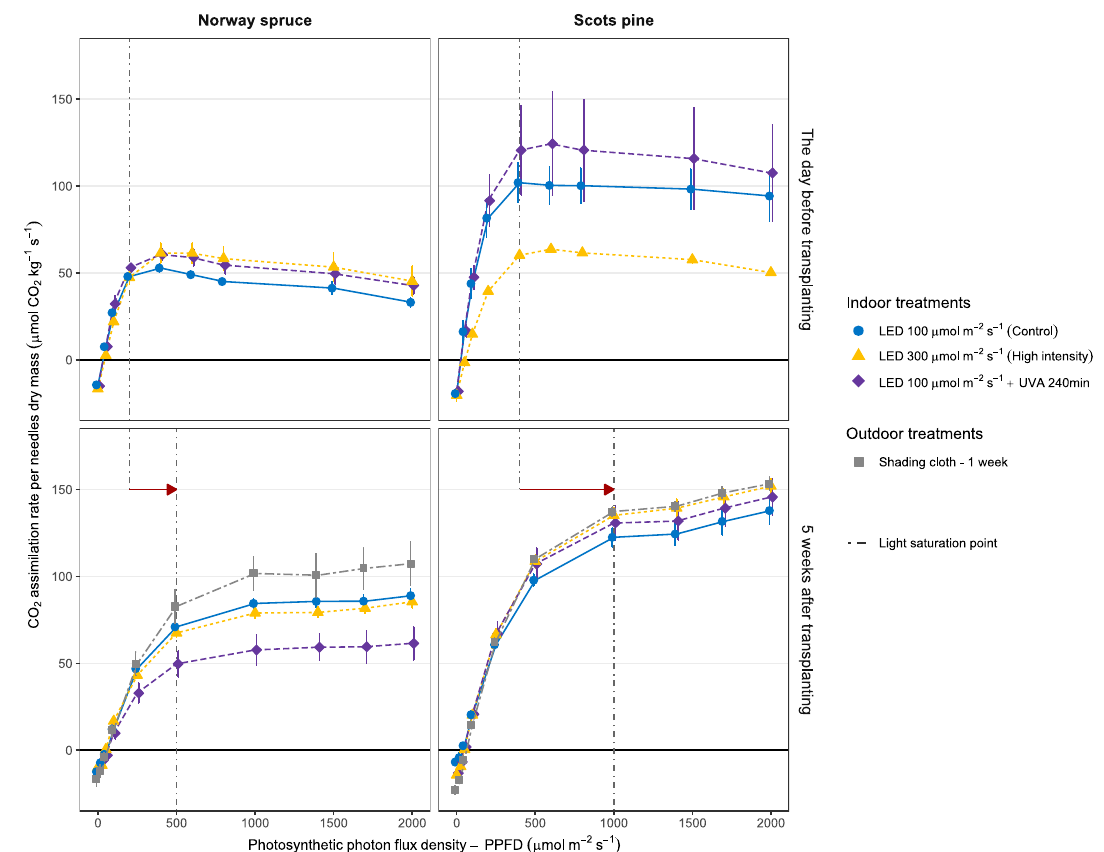
Figure 5. Average light-response curves for seedlings of Norway spruce and Scots pine cultivated indoors under LED lights. The net CO 2 assimilation was calculated relative to seedling’s needles dry mass as a function of the light intensity. The vertical dashed lines show the shift in the light saturation point after adapting to outdoor conditions. The error bars represent the standard error of the sample mean ( n = 3).